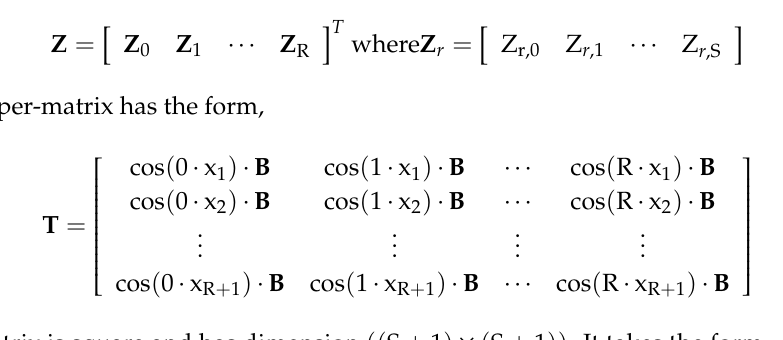
Figure A1. Discretization of the function’s area allows writing relations between the set of function